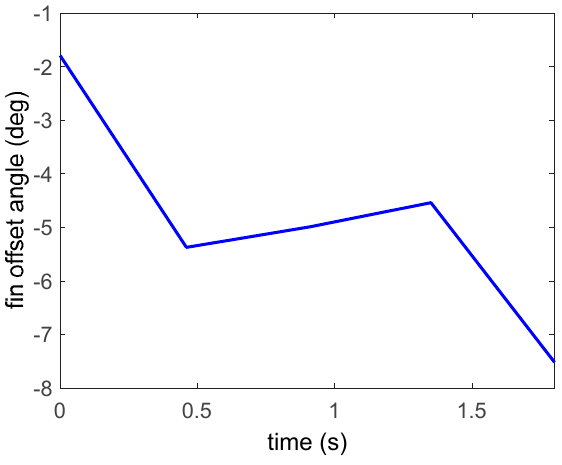
Figure 29. Identified time-varying offset angle offset u for first analysis period.